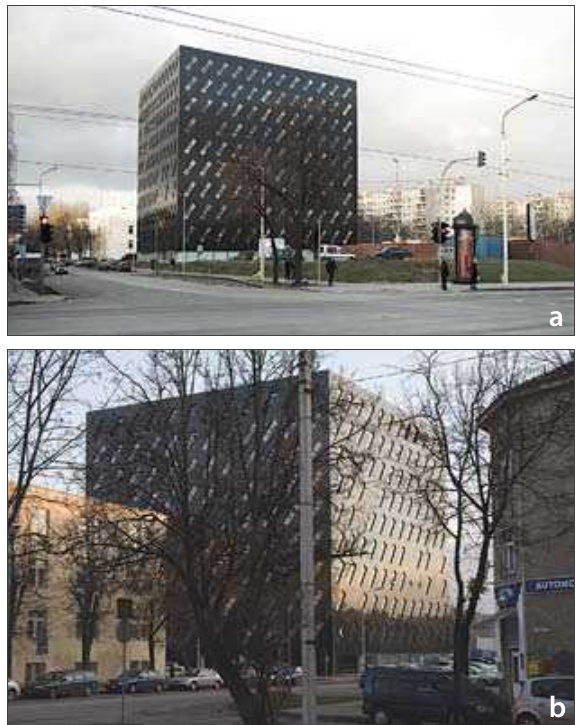
Fig. 22. Prosecutor's Office building (context) (a, b),